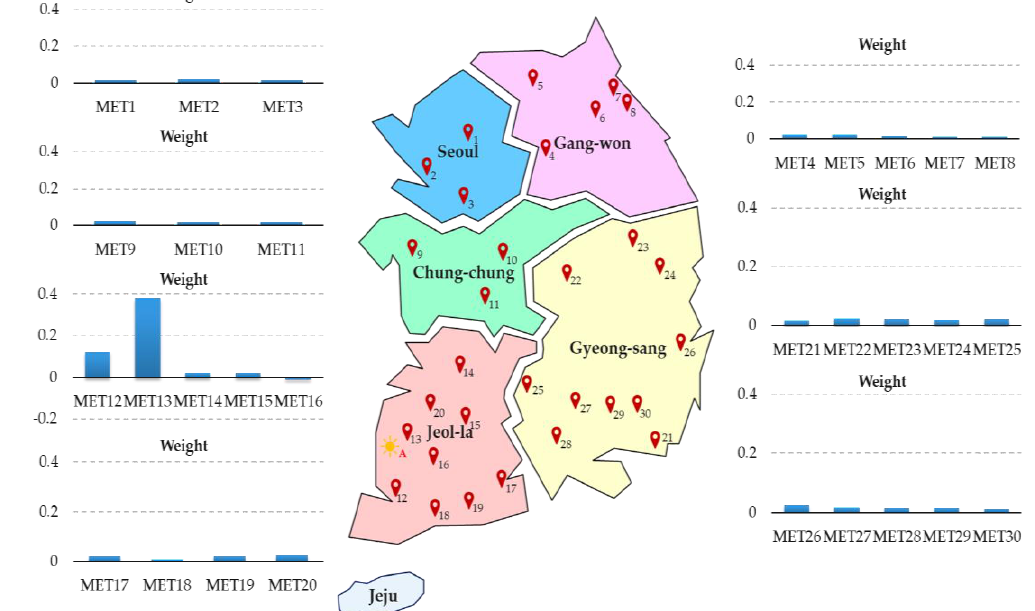
Figure 5. Locations and weights of METs.